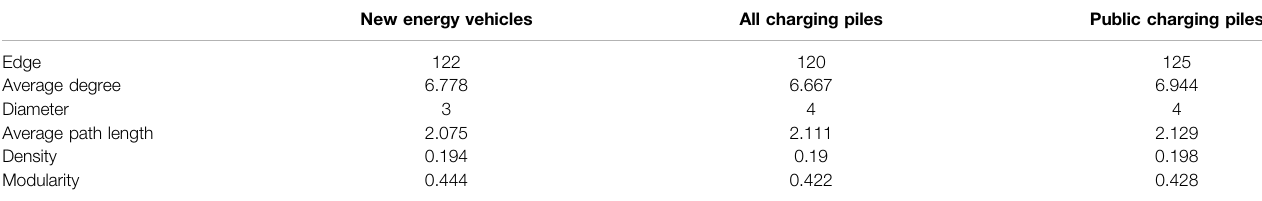
TABLE 3 | Network parameter